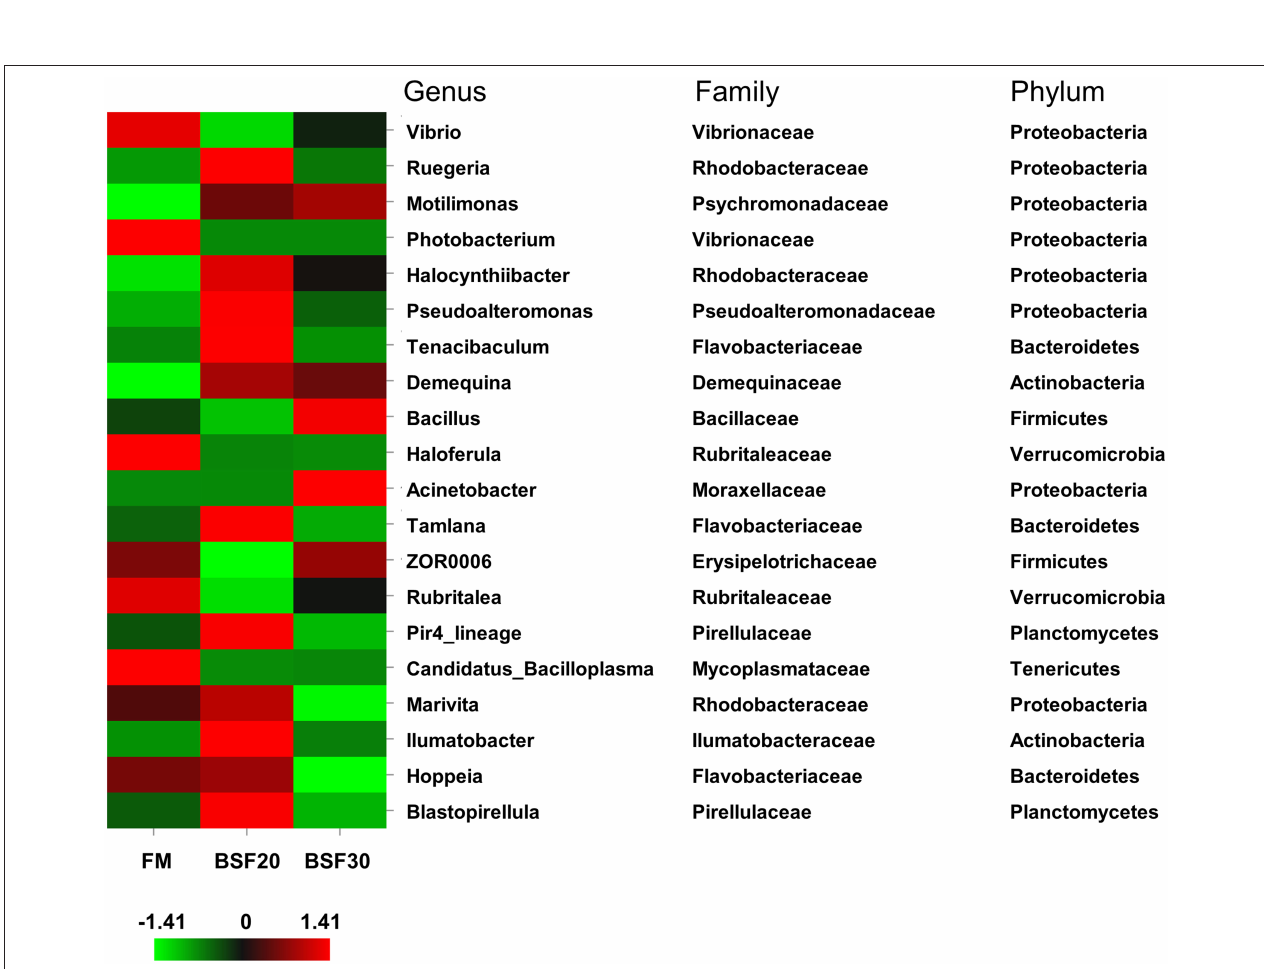
FIGURE 6 | Heatmap of top 20 abundance intestinal microbiota in L. vannamei fed with different diets at the genus level. The color bar of each genus is average of three samples in each group. The taxonomy of the genus (family and phylum) is depicted on the right.